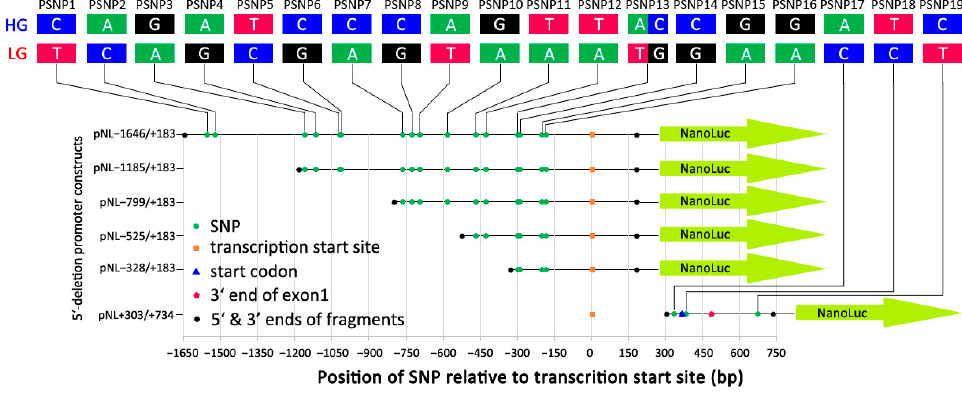
Figure 1. Schematic diagram of 5 ′ -deletion constructs and distribution of variants. Five-prime deletion and one intragenic fragment fused into the upstream region of the nanoluciferase gene to define the core promoter for transcription and to analyze the regulatory effects of variants. A total of 19 SNPs were found in the − 1646/+734 region and grouped into the high- and low-growth haplotypes (HG/LG) in the Advanced Intercross Line. Information on these SNPs is summarized in Table